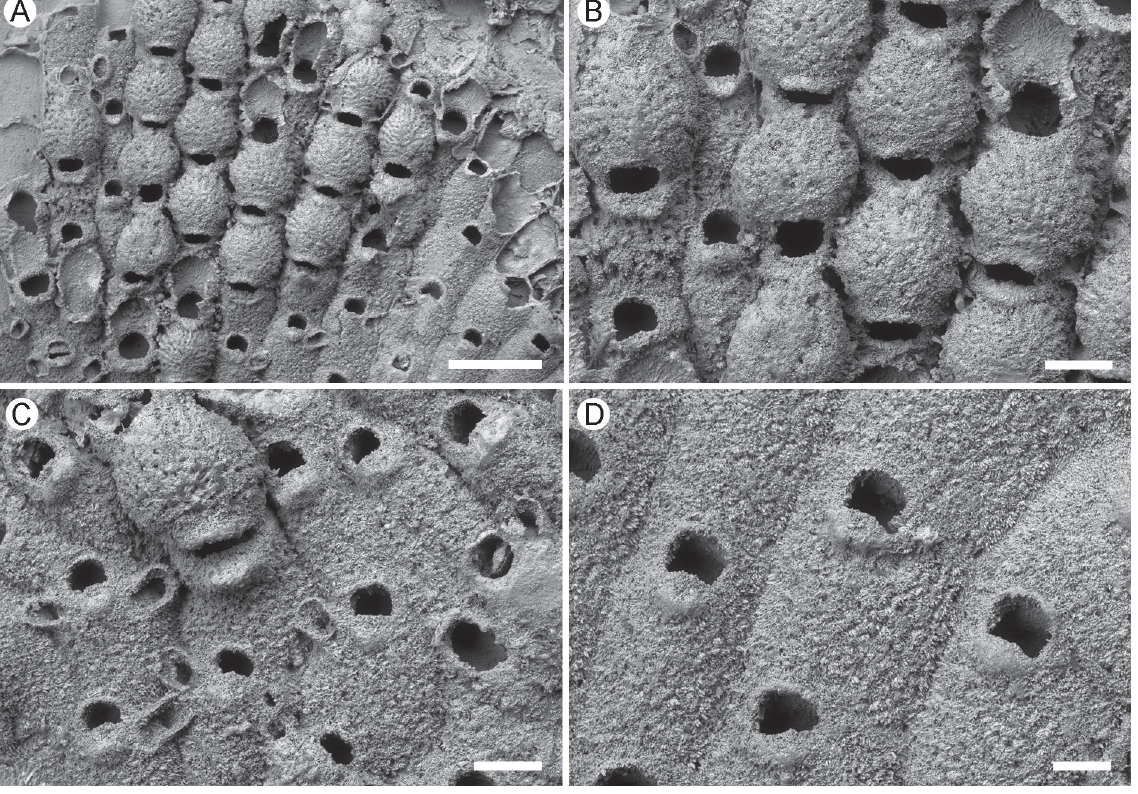
Fig. 5. Powellitheca waipukurensis (Waters, 1887) comb. nov. Specimen figured by Brown (1952: fig. 203), NHMUK D36986, Mangapanian, Early Pliocene, Hawkes Bay, Waipukurau Gorge. A . General view of the colony. B . Group of autozooids and fertile zooids showing the dimorphic orifices. C . Group of zooids with avicularia. D . Autozooids. Scale bars: A = 500 µm; B–C = 200 µm; D = 100